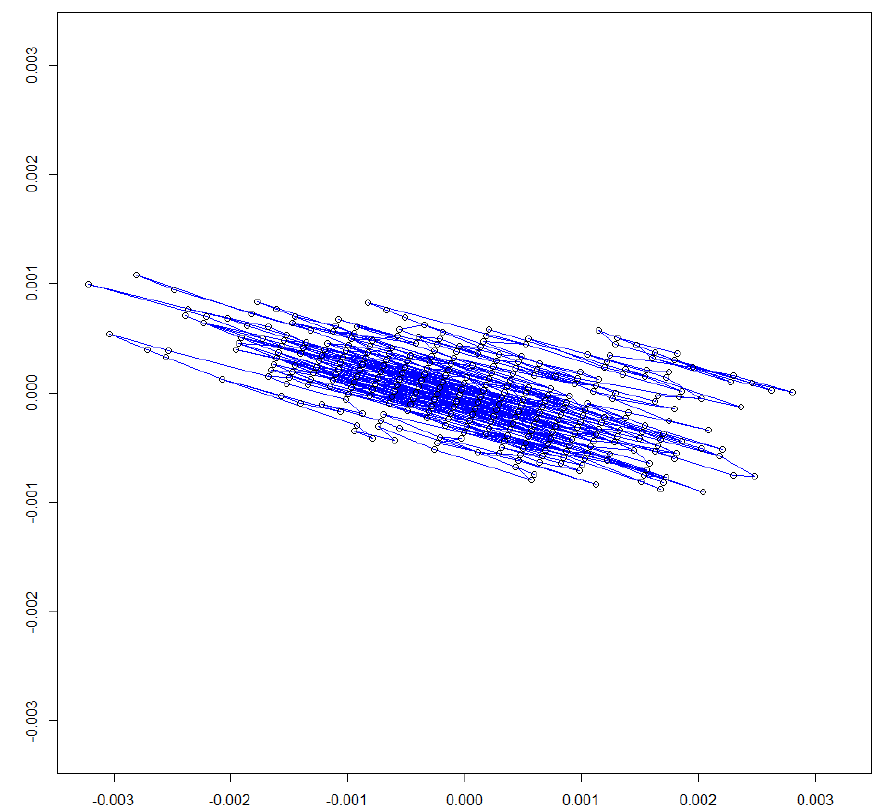
Figure 9. Stability measurement for orientation yaw = − 176.8162, pitch = − 17.0508 and roll = 109.87212. The difference between orientations has been measured by the L2 norm of the projection of the orientation on the unit sphere. The maximum error obtained is 1.135321 × 10 − 5 , which is equivalent to a maximum error in degrees of 0.1930557 in degrees.